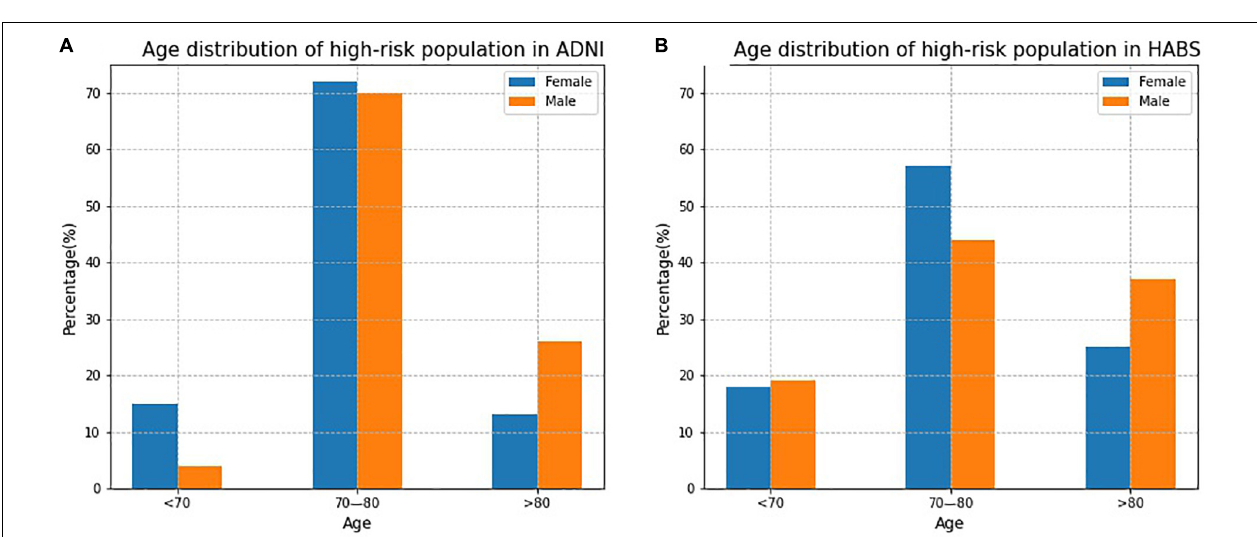
FIGURE 4 | Comparison of the risk of converting to MCI calculated by the SRSS-CNMCI by sex in ADNI and HABS.